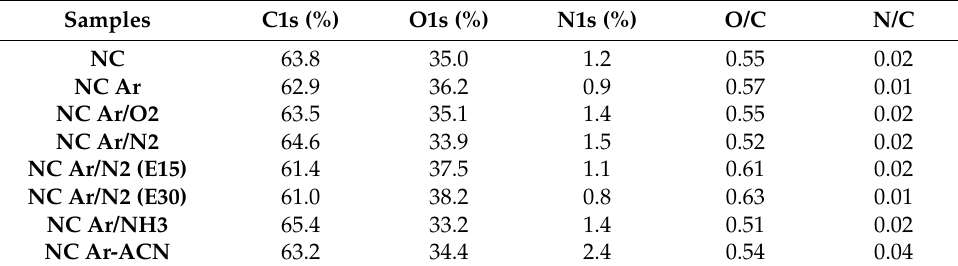
Table 3. Relative atomic concentrations of carbon, oxygen, and